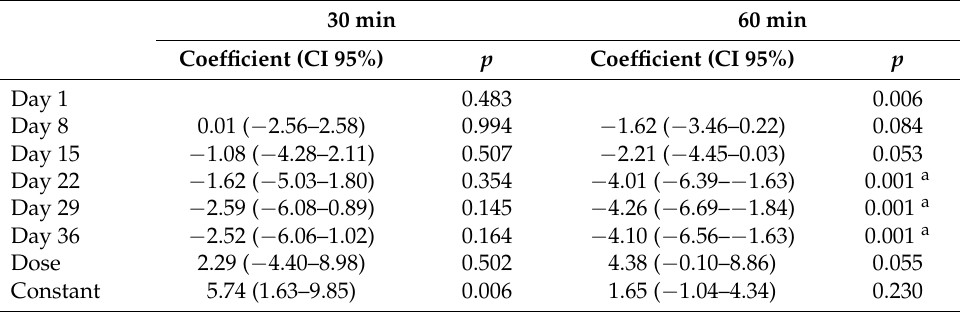
Table 2. CADSS mean score differences over time adjusted by dose (N = 70). Figure 1. Mean CADSS scores 30 and 60 min after the infusions.